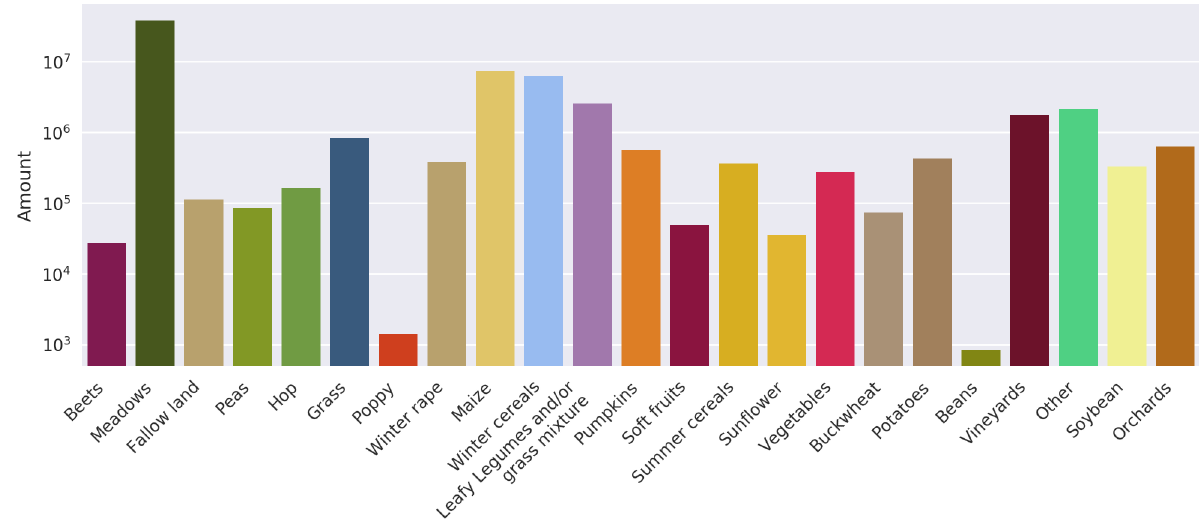
Figure 4. Crop distribution in Slovenia, the scale is logarithmic.